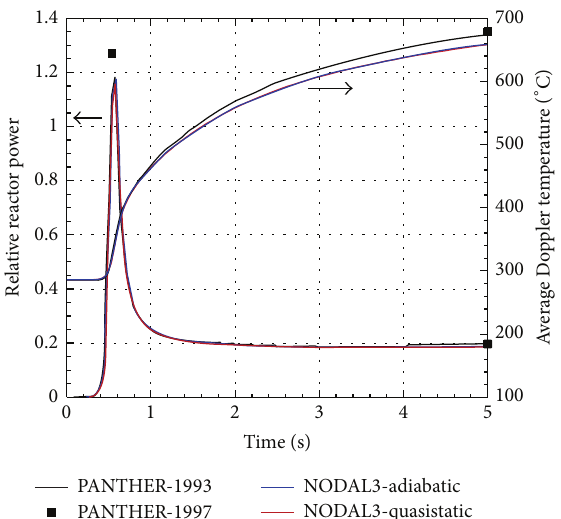
Figure 8: Comparison between NODAL3 and references results for case B1.